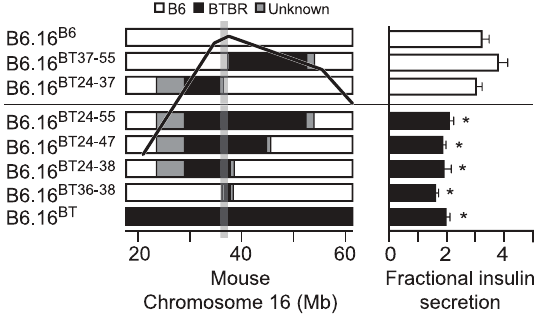
Figure 3. Effect on insulin secretion of introgressing 1.6 Mb of BTBR Chr 16 into B6 mice. Left panel: Congenic mice were generated by introgression of varying fragments of the BTBR chromosome 16 into the B6 mice. The B6/BTBR boundaries for each congenic strain were determined via microsatellite marker, SNP sequencing or DIP sequencing and are listed in Datasets S1 and S3. Overlaying the congenic diagram is the position of the fasting glucose QTL derived from a (B6 x BTBR) Lep ob/ob F2 intercross. Right panel: Fractional insulin secretion (% of islet insulin content) from the islets of the 10-week lean congenic mice. Isolated islets were incubated for 45 min in KRB-based buffer containing low glucose (1.7 mM). After 45 min, the islets were exposed to 8-bromo cAMP (3 mM) at sub- maximal glucose (11.1 mM) for another 45 min. Values are mean 6 S.E. of N $ 3. * p # 0.05 for fractional insulin secretion from islets of congenic mice that contains the 1.6 Mb fragment of the BTBR chromosome 16 mice vs. congenic mice carrying this 1.6 Mb fragment derived from the B6 strain.